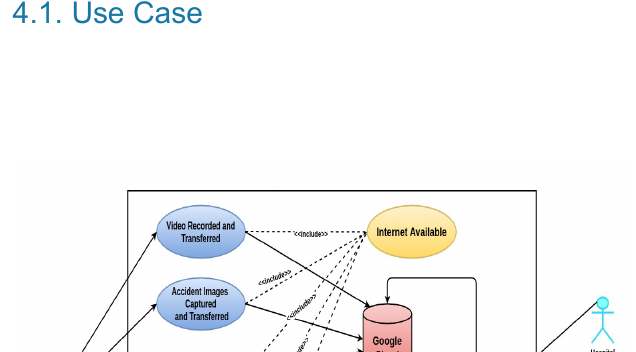
The accelerometer would provide information about the acceleration[29], 3-axis accelerometer (angle), and 3-axis gyro meter (angle), and the ultrasonic sensor provides information about the distance between the objects. The ultrasonic sensor and accelerometer would be used to detect whether the accident took place or not, i.e. if the acceleration of the vehicle is greater than 2.5g (>2.5 g) and the presence of any object is detected then the alert would be sent that the accident had taken place.